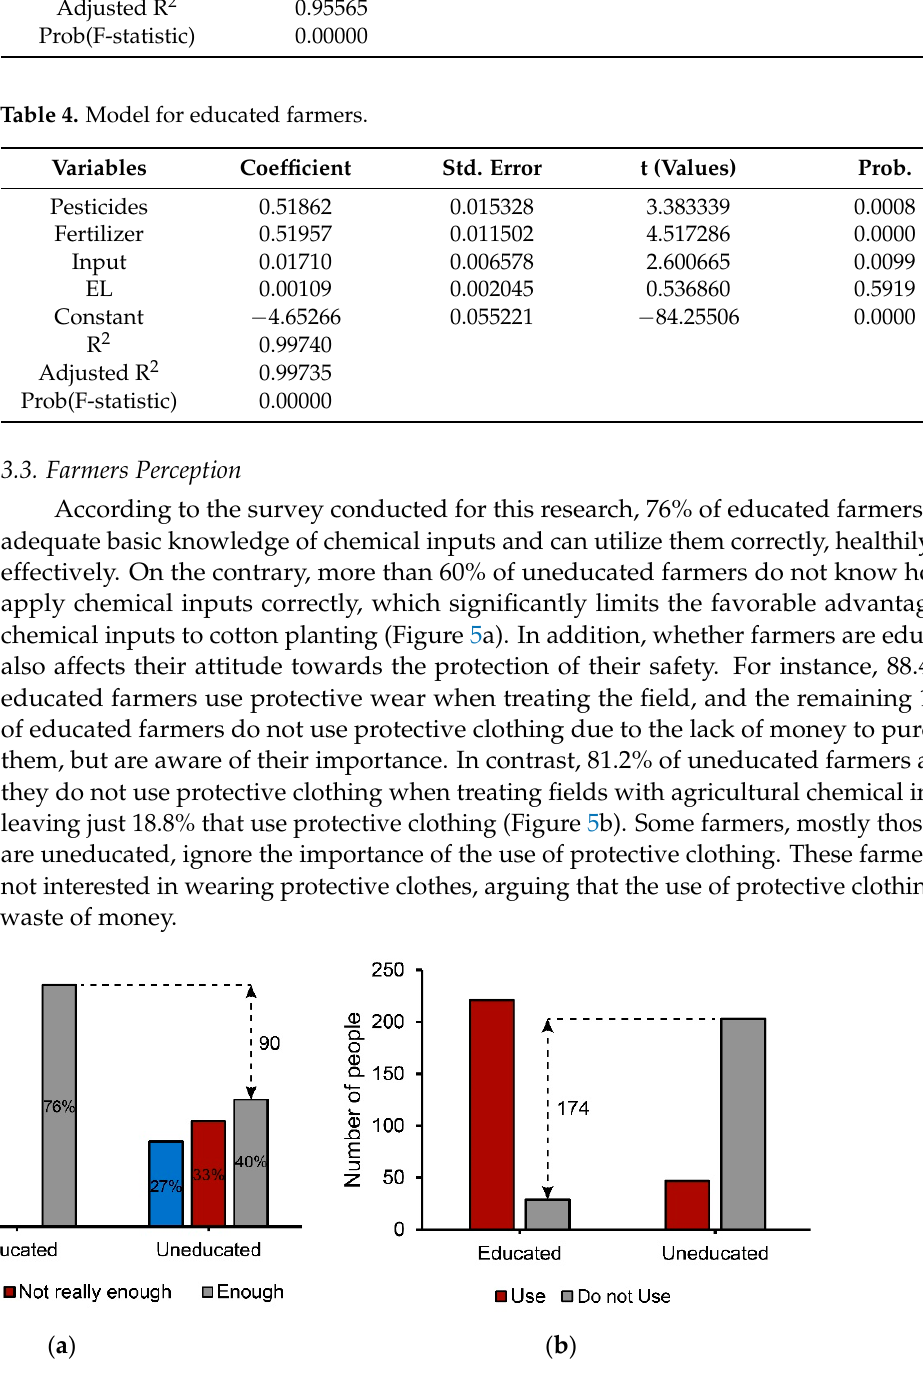
Figure 5. Perception of farmers on the effect of education linked to the use of agricultural chemical inputs. ( a ) Basic knowledge of farmers using agricultural chemical inputs. ( b ) Self-protection of farmers using chemical inputs.